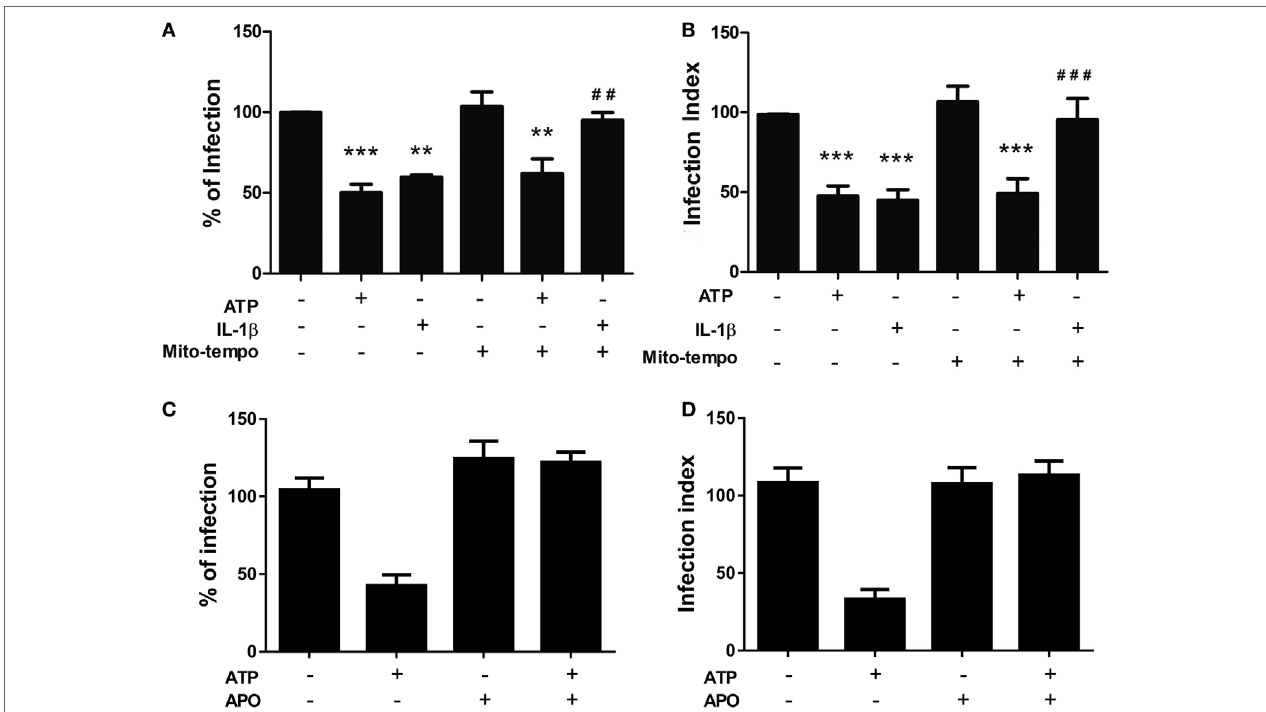
FigUre 6 | The control of T. gondii infection induced by extracellular ATP (eATP) and IL-1 β depends on different sources of reactive oxygen species generation. Peritoneal macrophages from C57BL/6 mice were infected with T. gondii tachyzoites for 2 h and left untreated or subjected to one or more of the following treatments: 100 nM Mito-TEMPO or 1 µM apocynin for 40 min, followed by 3 mM eATP or 1 ng/mL IL-1 β for 30 min. Then, cells were incubated at 37°C for a further 18 h, and the percentage of infected cells (a,c) , and number of parasites per host cell (B,D) were estimated by light microscopy examination, after staining with Panoptic. Normalized data represent mean ± SEM of three independent experiments performed in triplicates in (a,B) and two independent experiments in (c,D) . ## p ≤ 0.01 and ### p ≤ 0.001 vs. sample treated with ATP only; ** p ≤ 0.01 and *** p ≤ 0.001 vs. untreated (by one-way ANOVA followed by Tukey’s test).